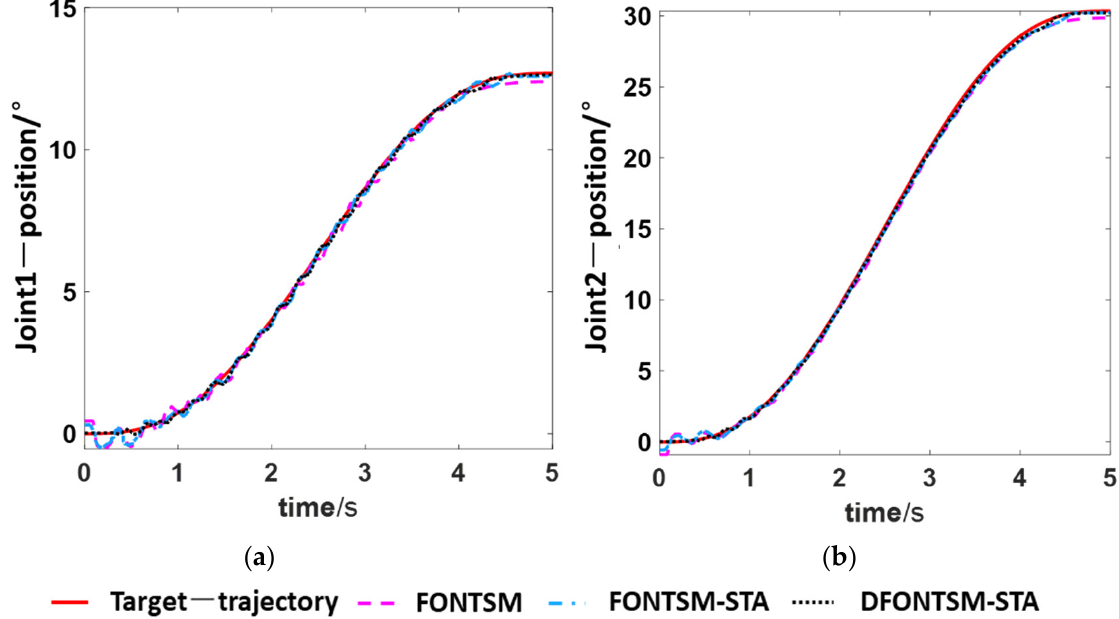
Figure 9. Position tracking trajectories of the shoulder joints. ( a ): joint one; ( b ): joint two.